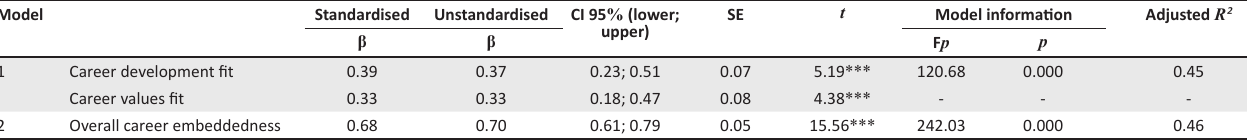
TABLE 6: Multiple regression of career embeddedness onto affective commitment. Model